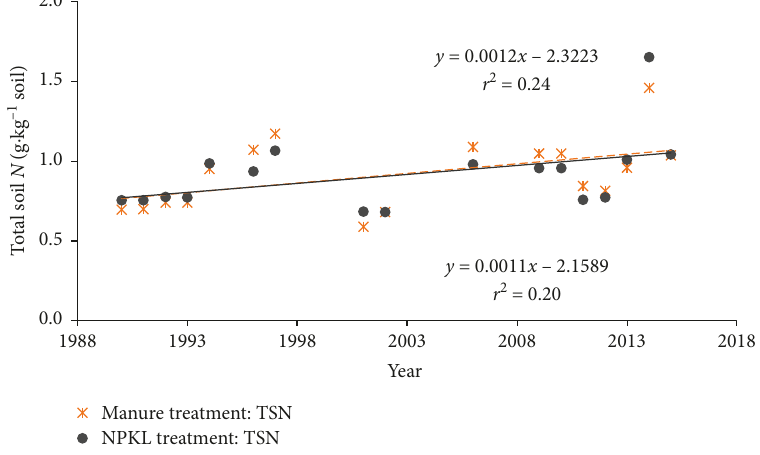
Figure 2: Total soil N accumulation in manure and NPKL treatments, 1990–2015.